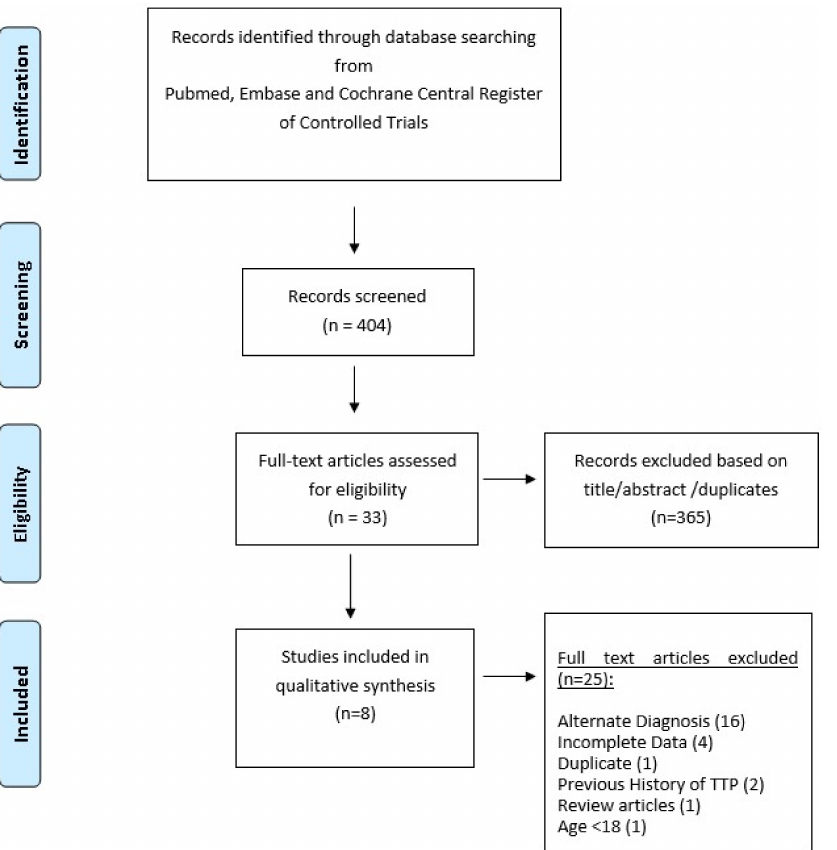
Figure 1. Preferred Reporting Items for Systematic Reviews and Meta-Analyses (PRISMA) flow diagram of included